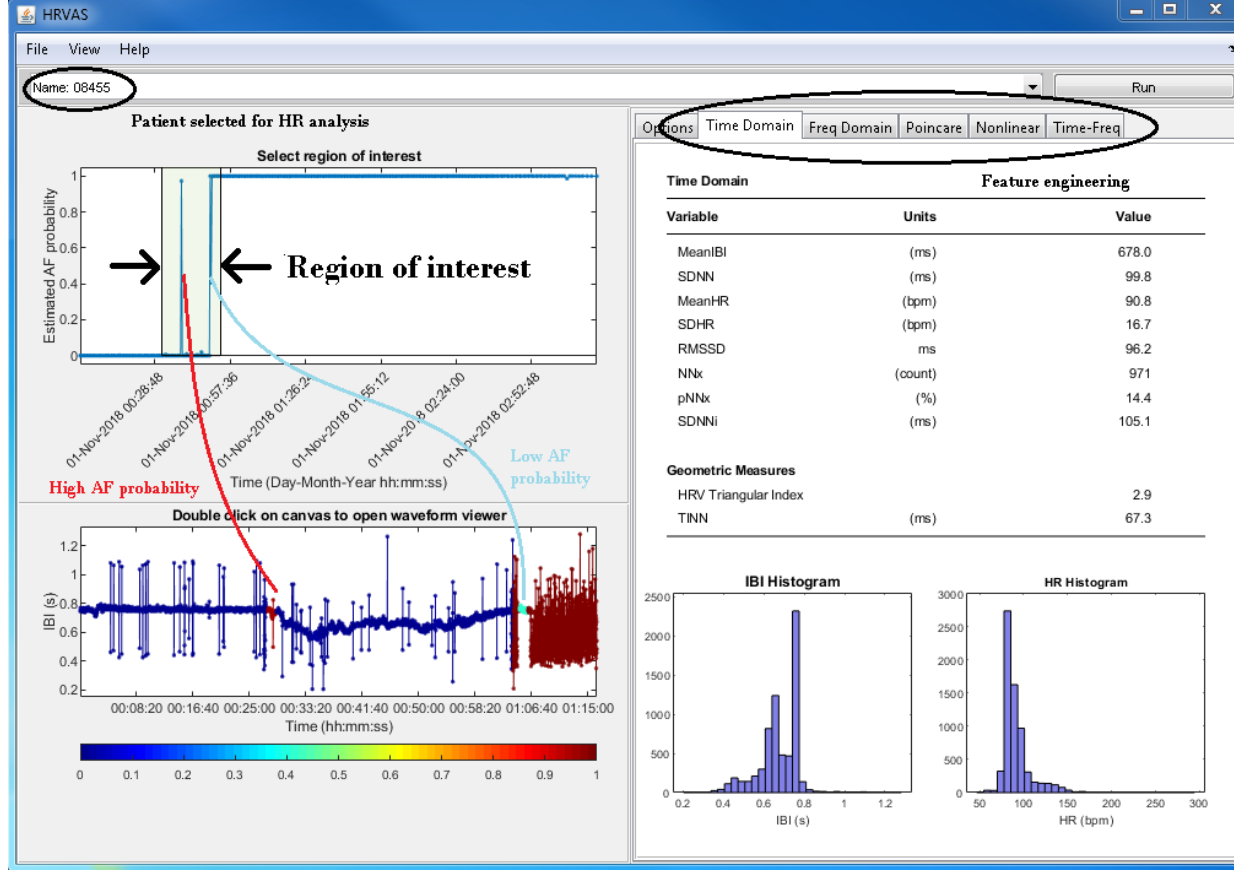
Figure 6. Screenshot of the modified HRVAS